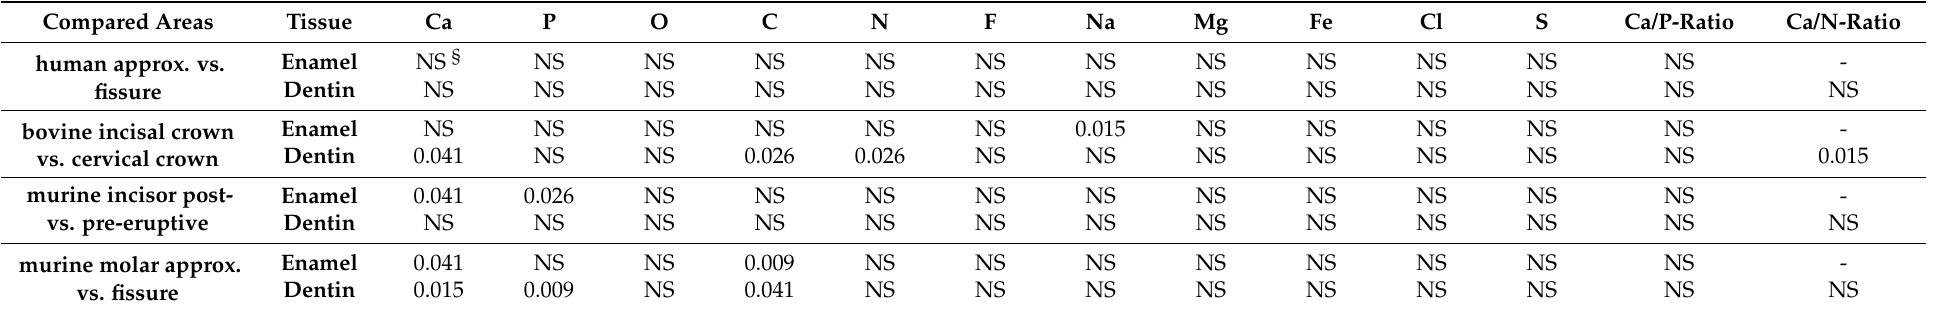
Table 5. p -values from pairwise tests between different measurement areas of the same dental hard tissues and the same type of teeth for all elements examined, as well as for the Ca/P- and Ca/N-Ratios (results depicted in Figure 6 and Table 1). Compared